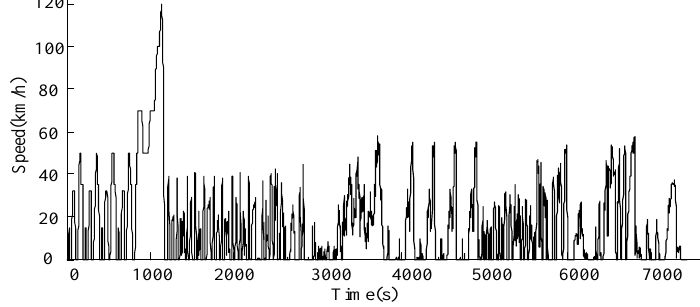
Figure 12. Time-speed relationship in the first class of driving cycles.